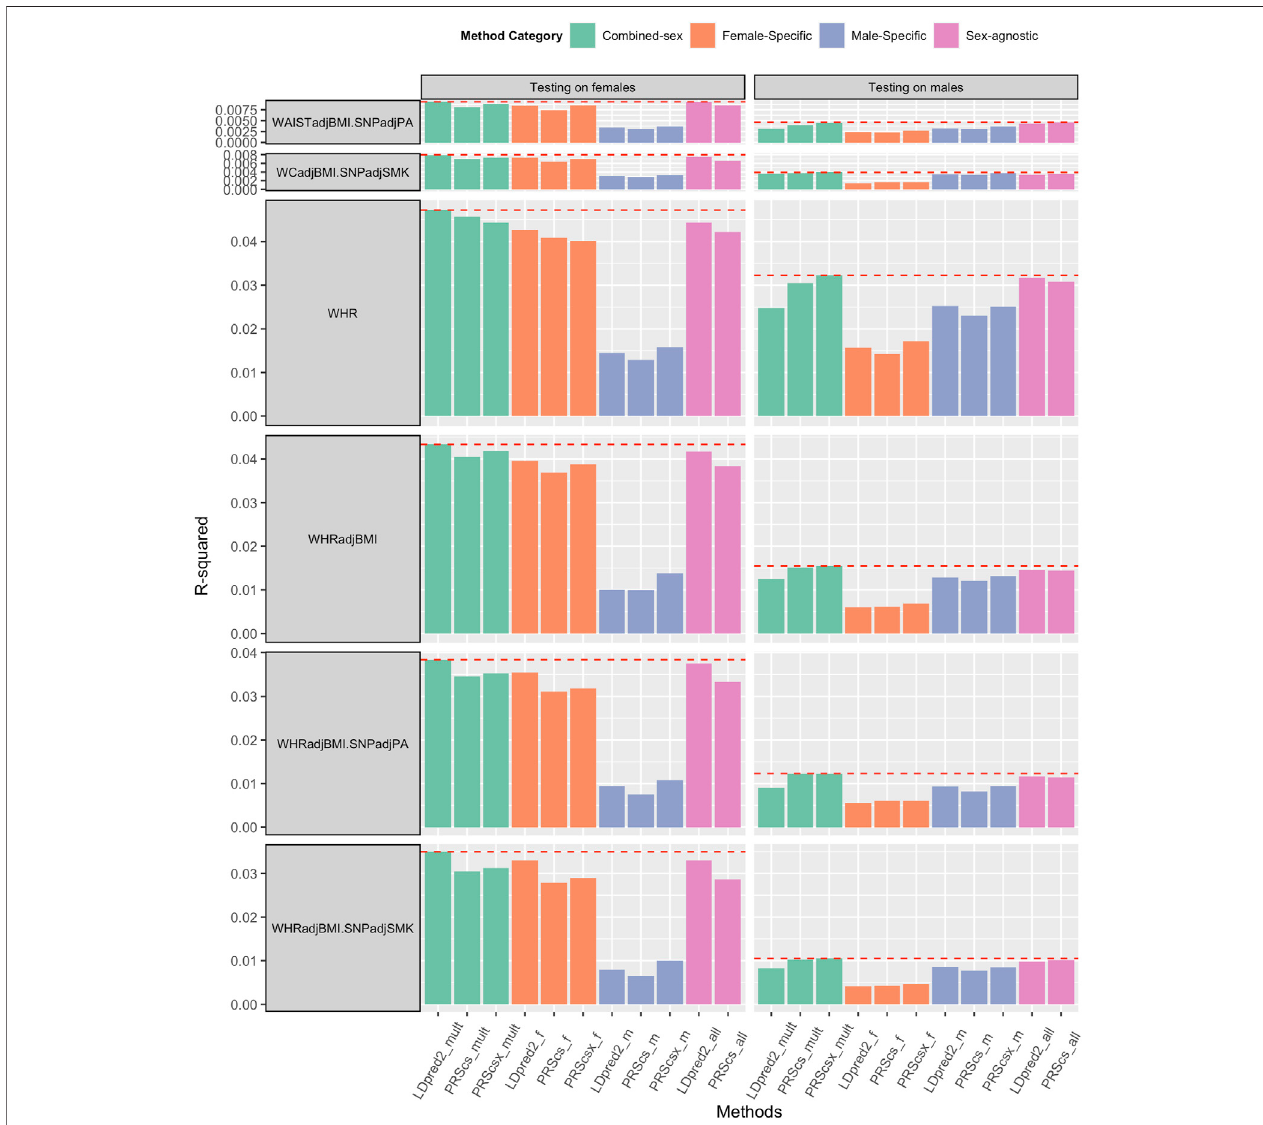
FIGURE 2 | Comparisons of PRSs on WHR and WHRadjBMI, WHRadjBMI.SNPadjPA and WHRadjBMI.SNPadjSMK, and WCadjBMI.SNPadjPA and WCadjBMI.SNPadjSMK (WHR: waist and hip ratio; WHRadjBMI: WHR adjusted by BMI; WHRadjBMI.SNPadjPA: with physical activity level as a covariate; WHRadjBMI.SNPadjSMK: with smoking status as a covariate; WCadjBMI.SNPadjPA: with physical activity level as a covariate; WCadjBMI.SNPadjSMK: with smoking statusasacovariate). Female-Speci fi c: Usingfemale-speci fi cGWASsummarystatisticsasinput. Male-Speci fi c: usingmale-speci fi